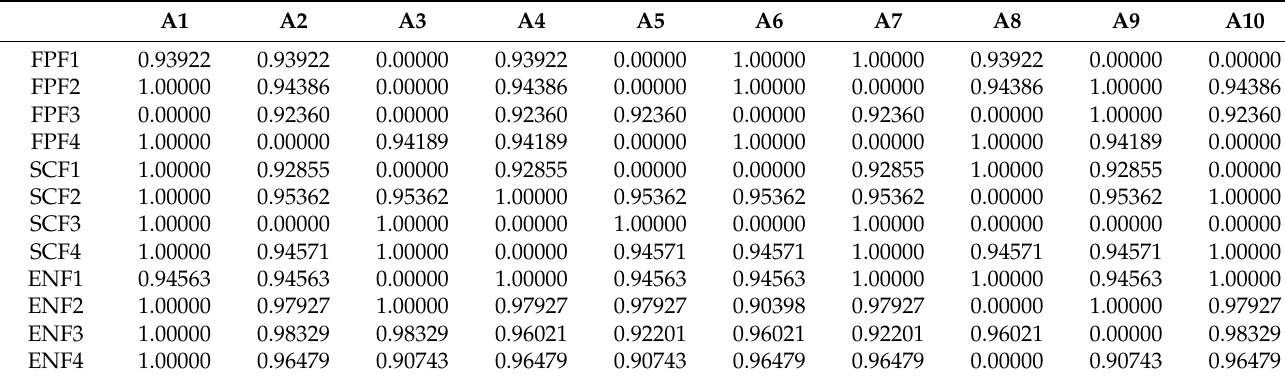
Table 3. Exponentially weighted comparability sequence and P i .